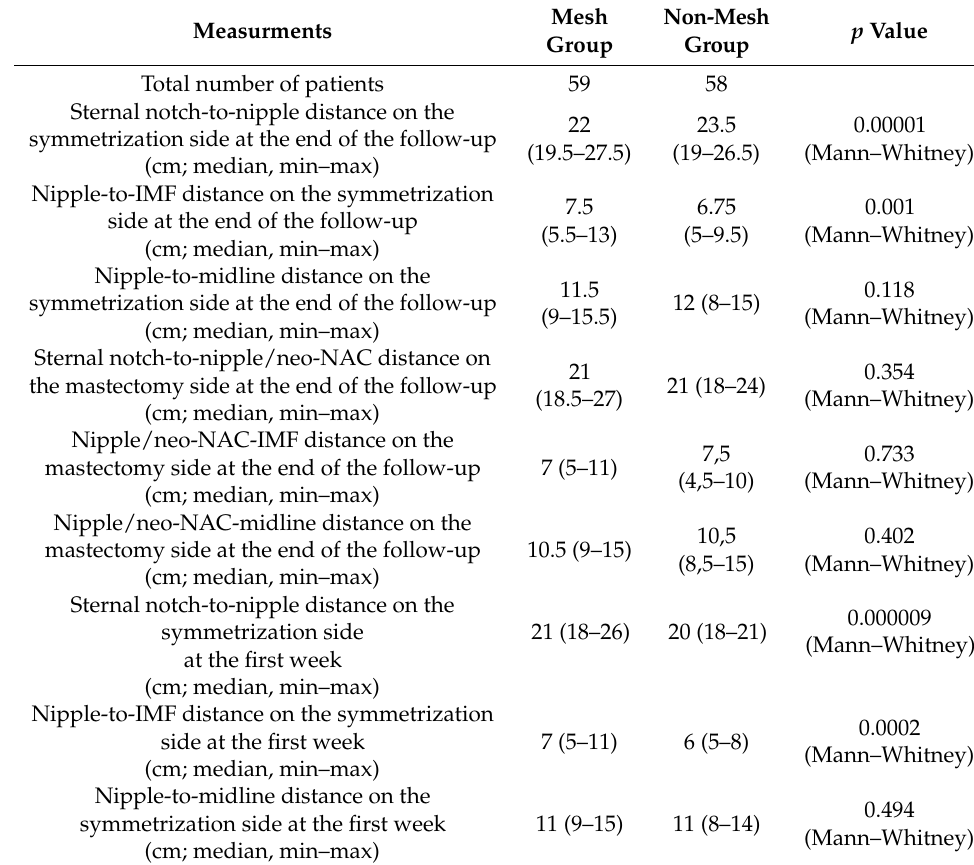
Table 4. Sternal notch-to-nipple, nipple-to-midline, and nipple-to-IMF